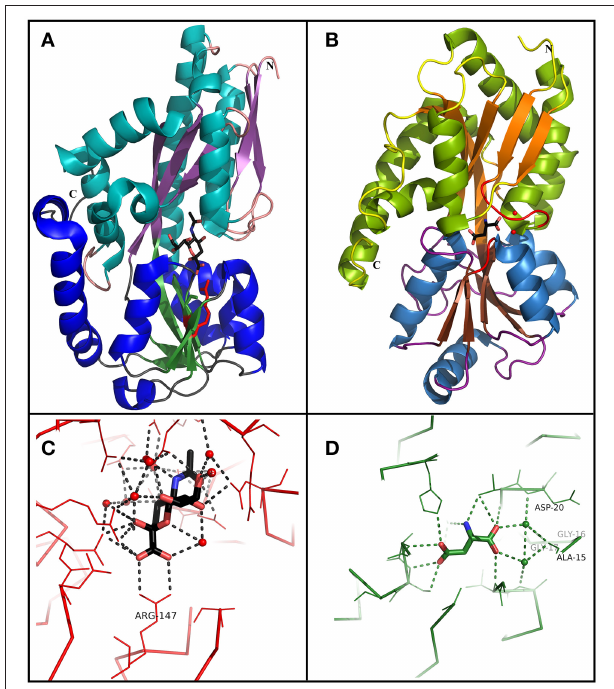
FIGURE 3 | Comparison between TRAP and TTT SBP crystal structures. (A) Overall structure of SiaP, a sialic acid binding SBP from the TRAP family in H. influenzae (PDB 3B50). Domain 1 is represented in cyan ( α -helix) and purple ( β -sheet), and domain 2 is represented in blue ( α -helix) and green ( β -sheet). A sialic acid molecule is shown in the binding pocket. Arg147, important to perform a salt bridge with the carboxylic group of the substrate in most SiaP homologs is shown in red. (B) Overall structure of BugD, a aspartate binding SBP from the TTT family in B. pertussis (PDB 2F5X). Domain 1 is represented in green ( α -helix) and orange ( β -sheet), and domain 2 is represented in blue ( α -helix) and brown ( β -sheet). An aspartate molecule is shown in the binding pocket. Two loops, between β 1 and α 1 and between β 7 and α 6, are involved in the conserved coordination of two water molecules, which bridge hydrogen bonds with the proximal carboxylic group in the substrate. These loops and waters are shown in red (C) Binding pocket of SiaP, showing the coordination of the sialic acid molecule. Arg147 perform a salt bridge with the carboxylic group in the substrate. The remaining of the molecule is coordinated by hydrogen bonds and water molecules which are variable inside the TRAP family. (D) Binding pocket of BugD, showing the coordination of the aspartate molecule. The residues Ala-15, gly-16, gly-17, and Asp-20 participate in the loop between β 1 and α 1, coordinating two water molecules which bridge hydrogen bonds with the proximal carboxylic group in the substrate. This coordination is very conserved among the TTT family. The remaining substrate coordination occur through non-conserved hydrogen bonds and water